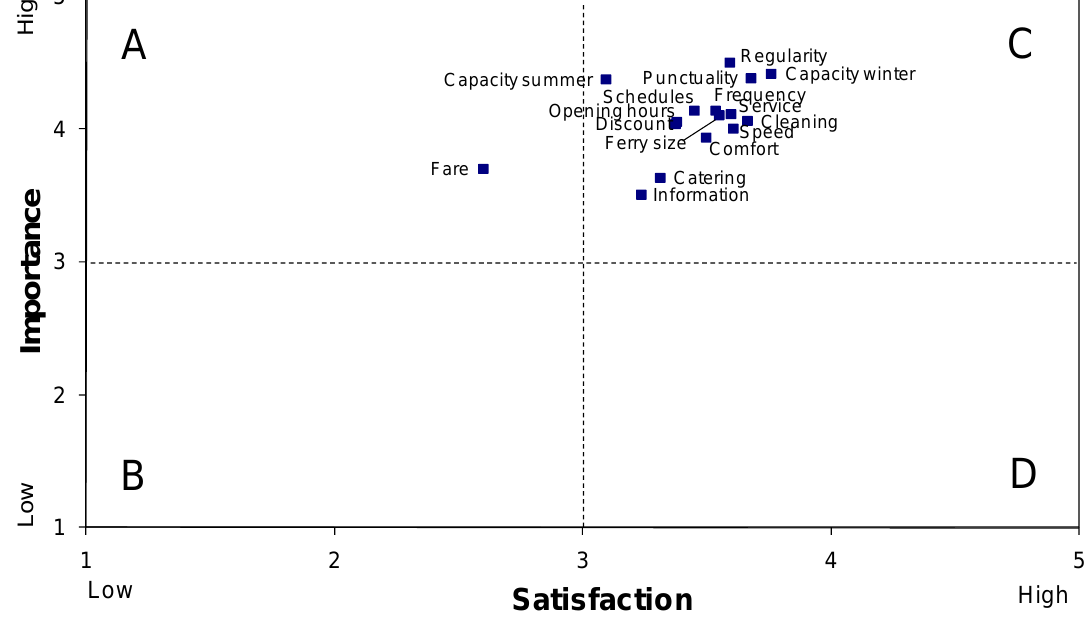
Figure 2. Households assessment of importance and satisfaction with service elements in the Norwegian ferry